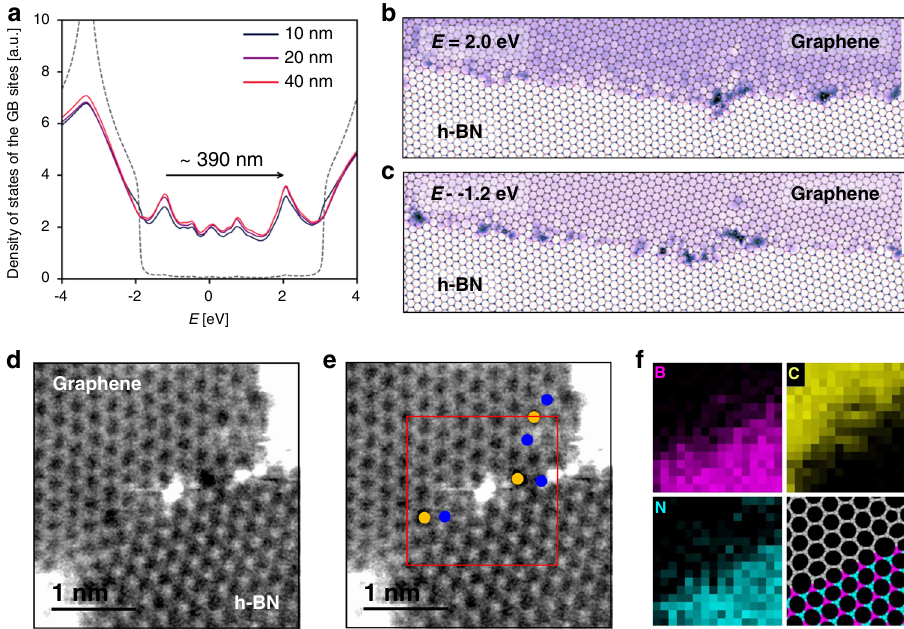
Fig. 3 Disordered G/h-BN junctions and their electronic properties. a Local density of state projected over all the sites at the graphene/h-BN interface for three different polycrystalline samples with 10 nm, 20 nm and 40 nm average grain size. As reference, dotted line corresponds to the density of states of a polycrystalline h-BN sample to show the energy location of the band gap. b , c Local density of states of each site in a disordered interface at 2.0 eV and − 1.2 eV, respectively. It is clear that local density of states is higher at the structural defects of the interface. The units used are arbitrary. d , e Annular dark- fi eld (ADF) STEM image showing a boundary between graphene and h-BN domains (top and bottom, respectively). Blue and orange circles denote 5- and 7-membered rings, respectively. The bright impurity atom found in the red box of e is identi fi ed as silicon by EELS, probably coming from the sample transfer process. f STEM-EELS elemental maps of boron, carbon, nitrogen and a possible structure model for the area indicated by a red square in e